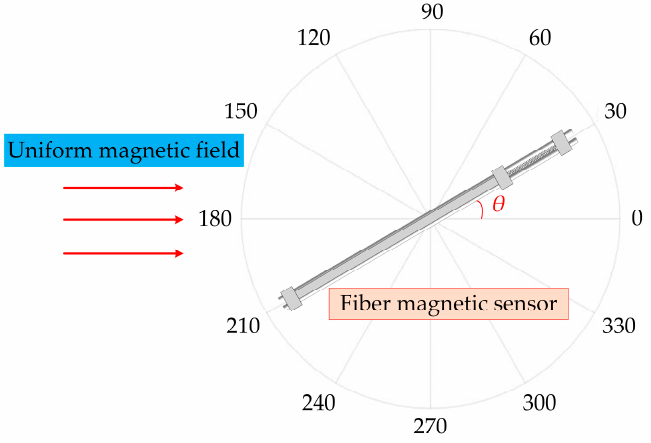
Figure 10. Directivity test of optical fiber magnetic field sensors.